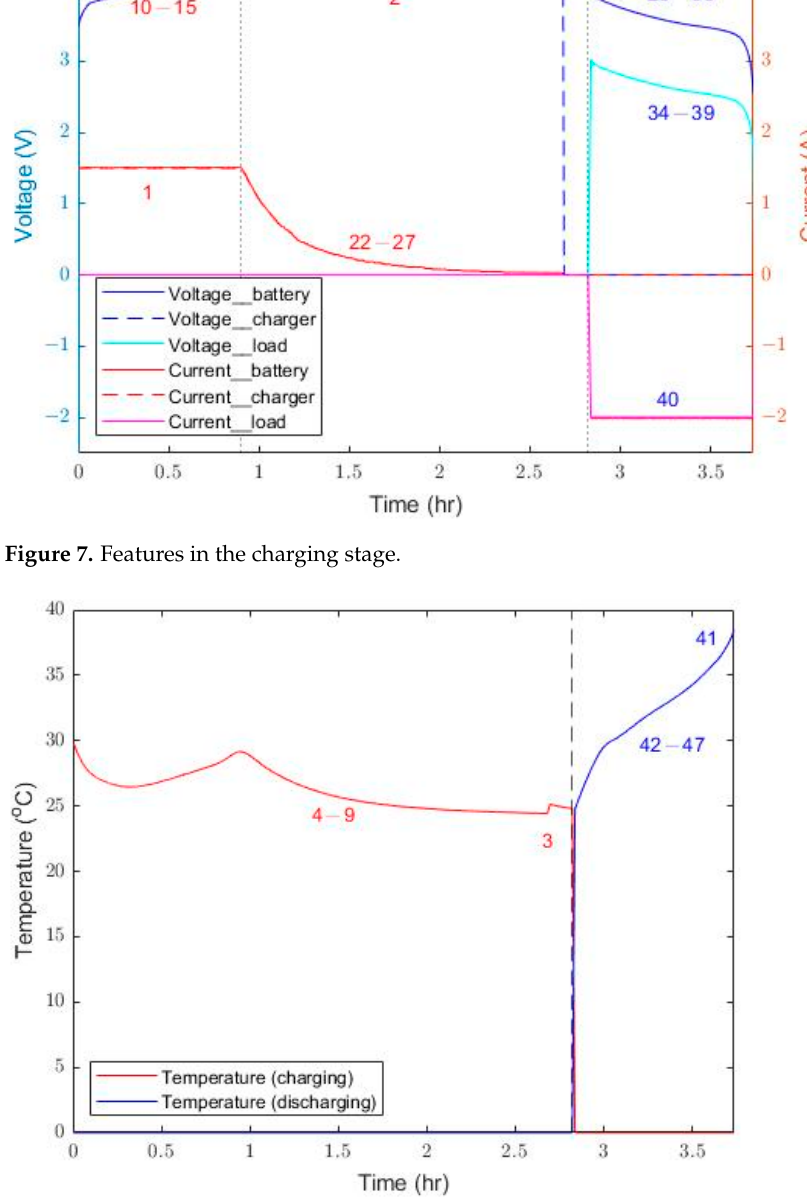
Figure 8. Features in the discharging stage.